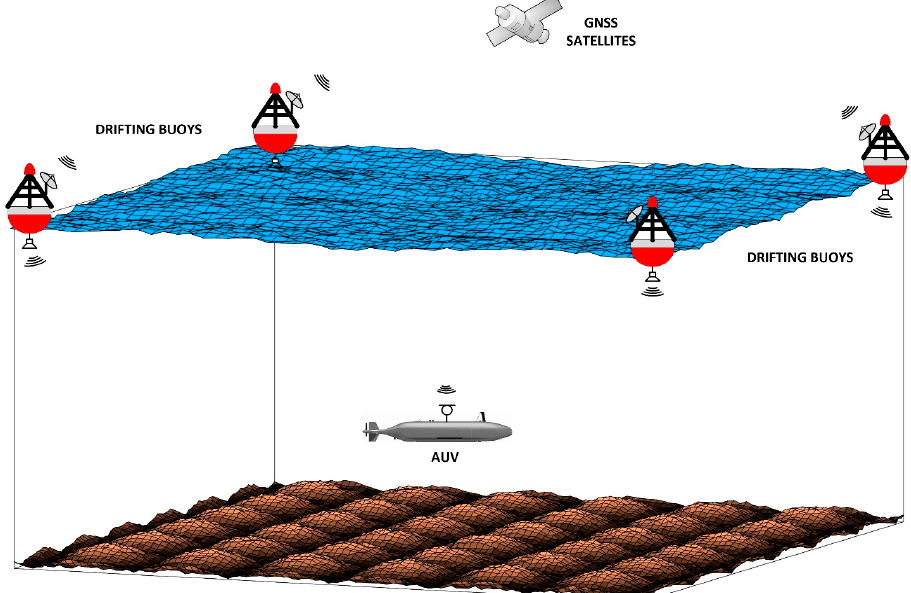
Figure 1. System sketch.